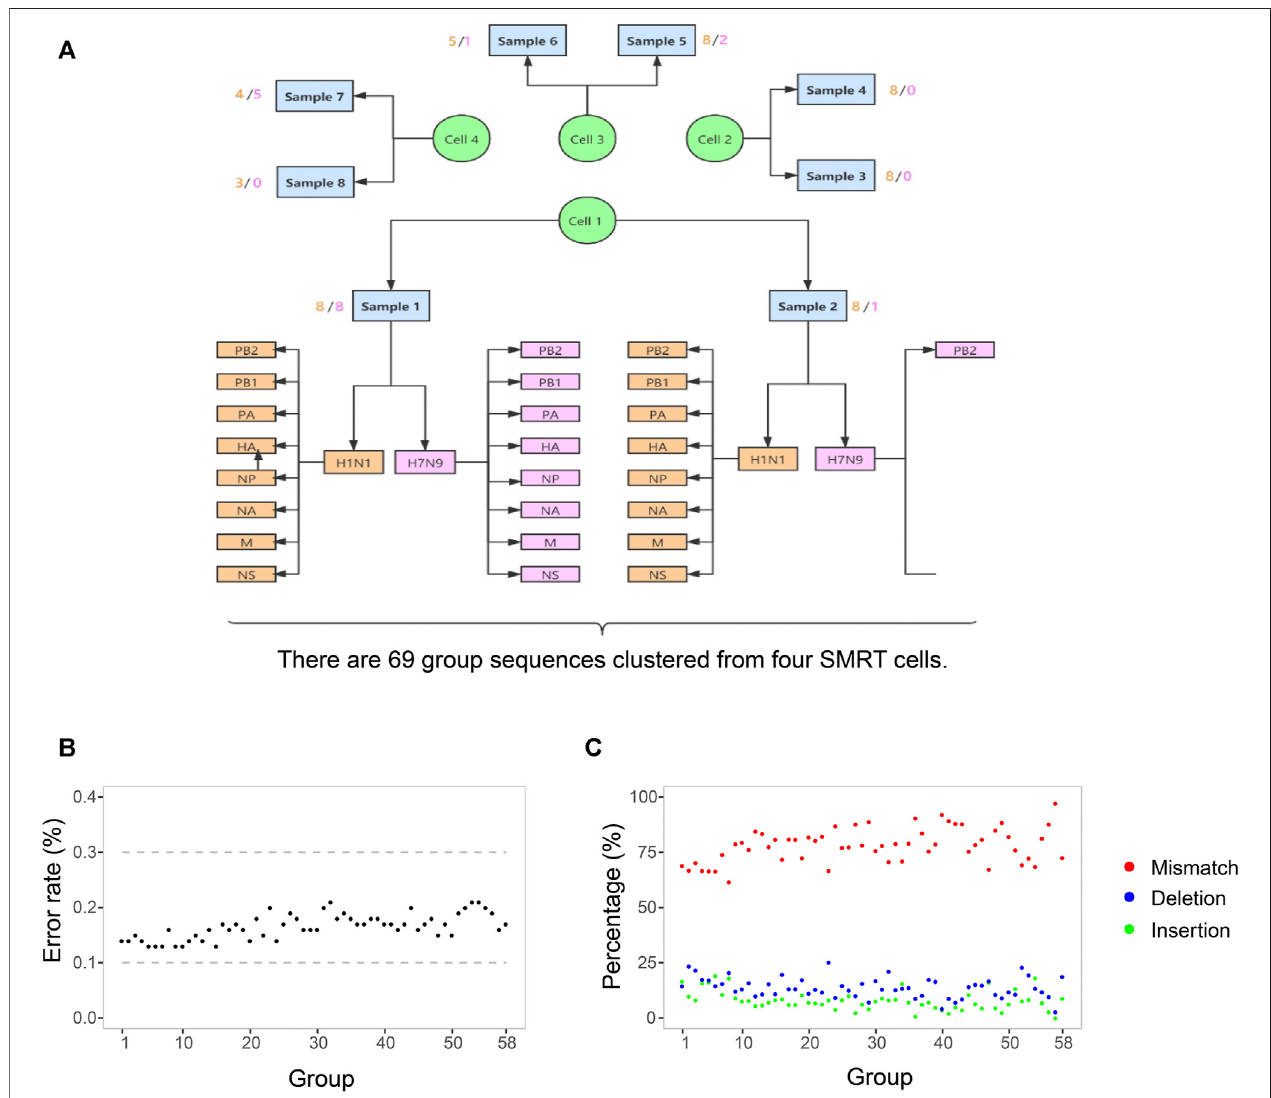
FIGURE 1 | The process of sequences grouping and the SMRT sequencing error rate. (A) There are 69 group sequences clustered from four SMRT cells by samples, subtypes, and genomic segments. The sequences in one group indicates that they are with the same sample resource, the same In fl uenza subtype, and the same genomic RNA segments. The light yellow and pink fi gures around each sample indicate the number of groups of H1N1 and H7N9. (B) The base sequencing error ratesof58groupsequences.Ineachgroup,thenumberofsequencesismorethan20.Therateistheratioofthenumberofsequencingerrorbasestothenumber of total bases in one group sequences. (C) The three types and their percentage of sequencing error bases. red indicates mismatch, blue indicates deletion, and green indicates insertion. The percentage is the ratio of the number of one type of sequencing error bases to the number of total sequencing error bases in one group sequences. The detailed values about sequencing error bases in each group are listed in Supplementary Table S2